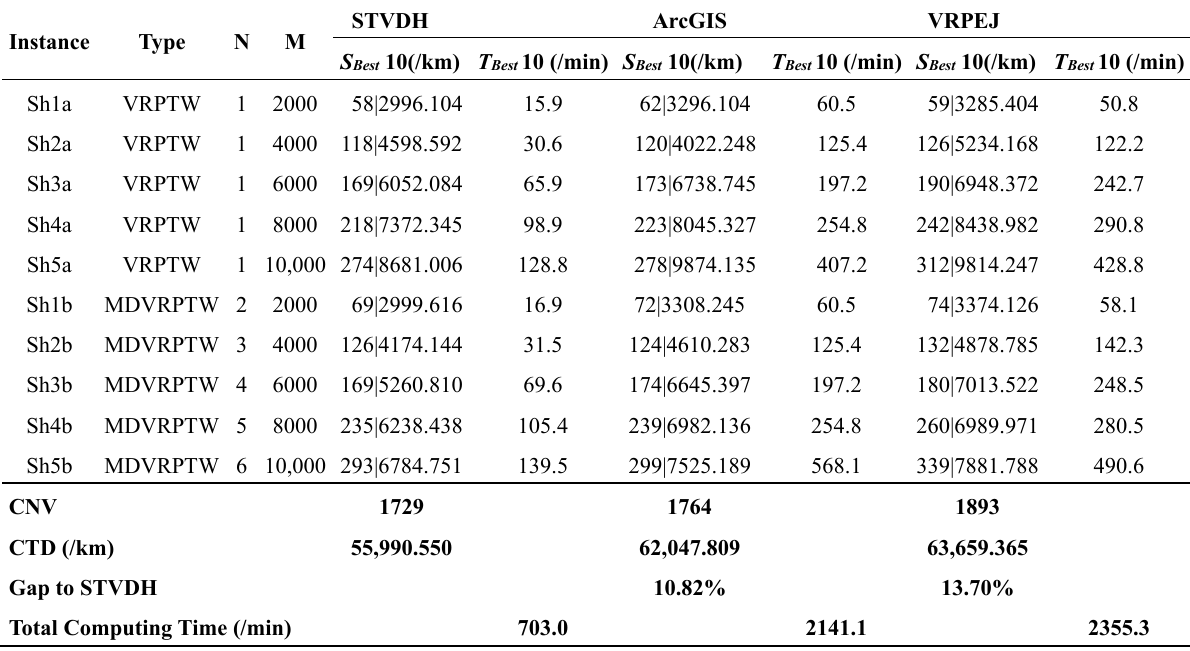
Table 5. Comparison of the results of the STVDH with other heuristic